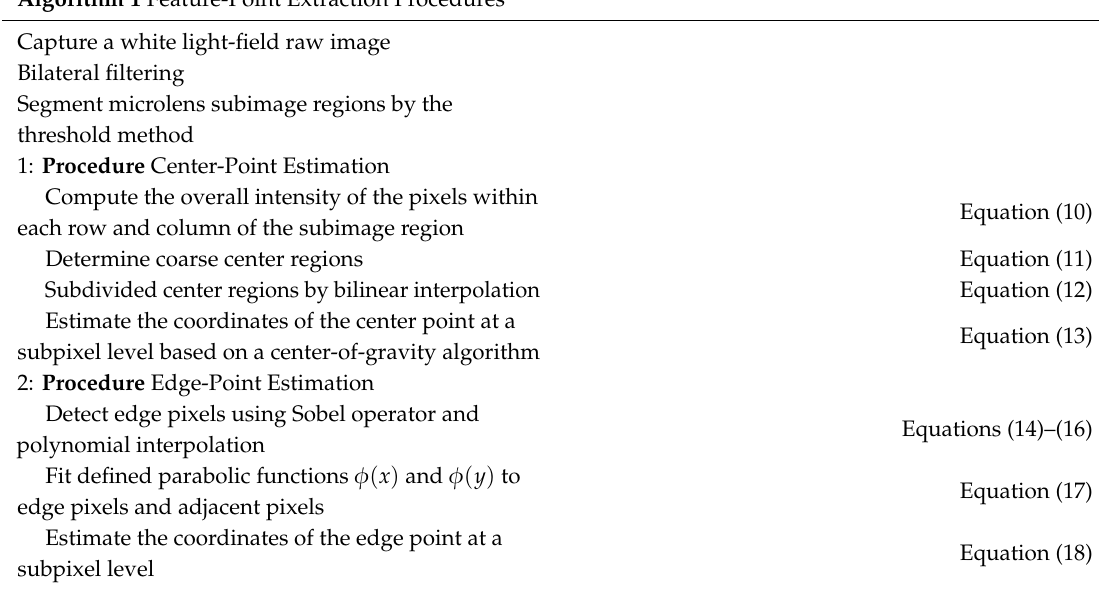
Algorithm 1 Feature-Point Extraction